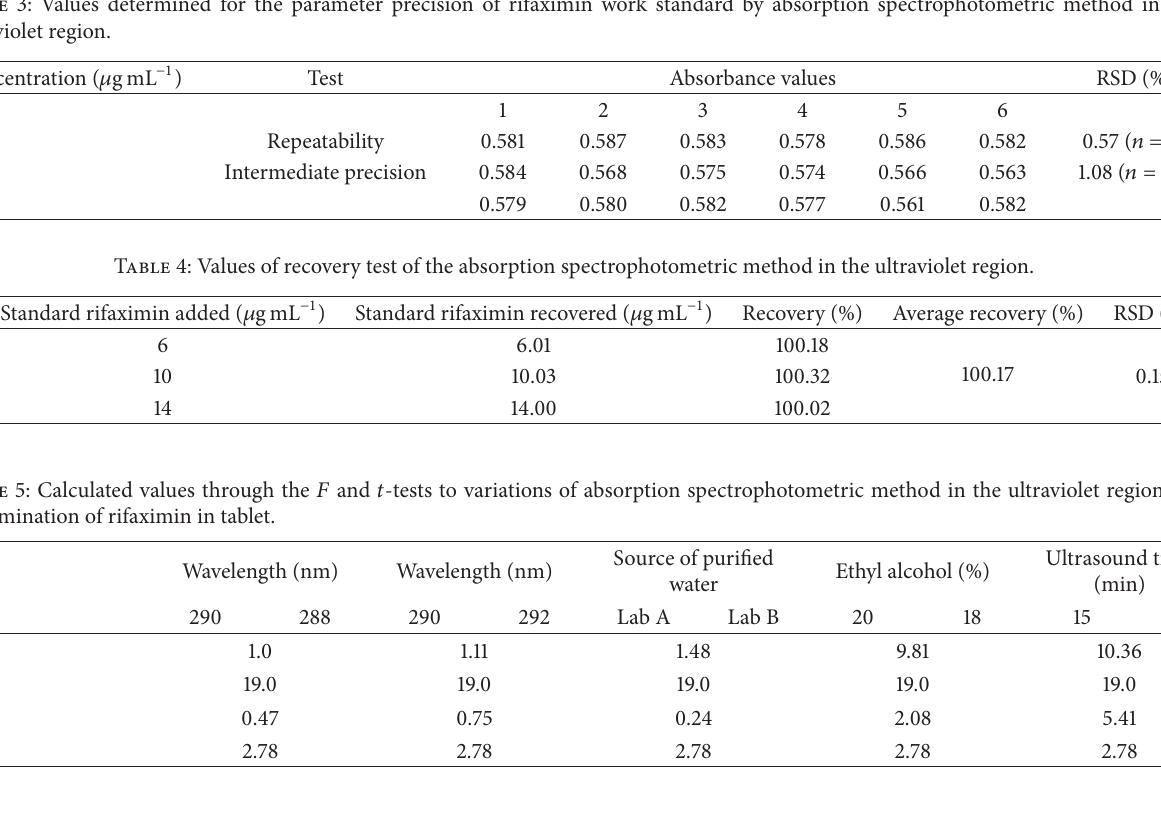
Table 6: Values determined for the assay of rifaximin in tablets by absorption spectrophotometric method in the ultraviolet